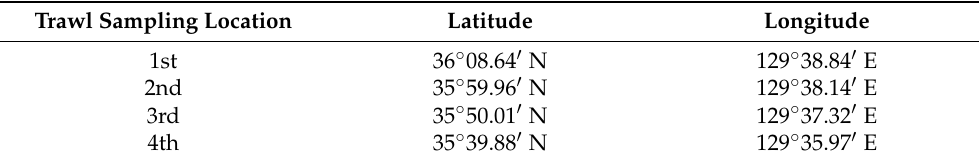
Table 1. Trawl sampling location in the survey area.